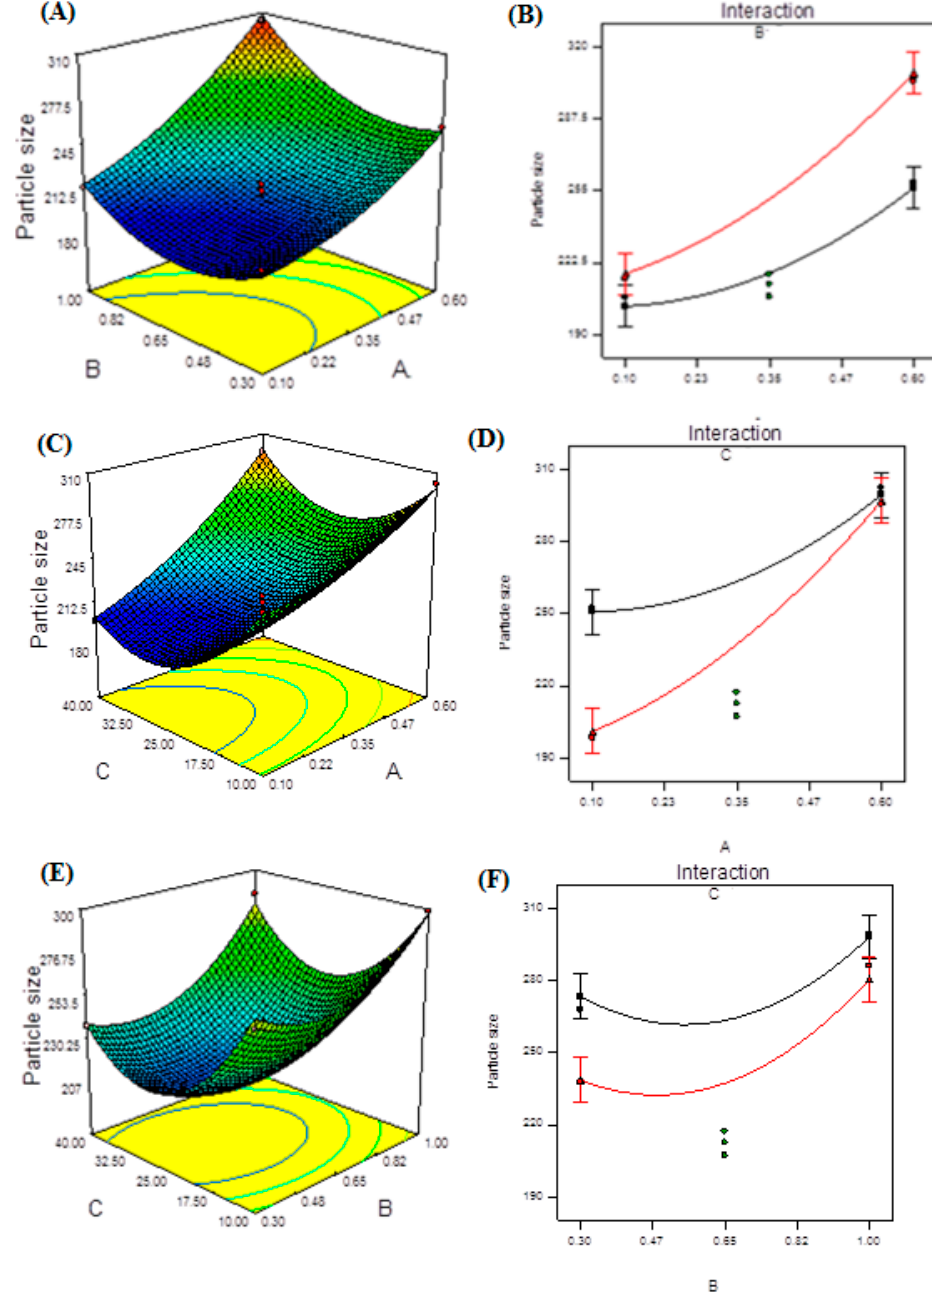
Figure 3. Model graphs: particle size. ( A ) Three-dimensional response surface plots showing the effect of variables (A: TPP concentration and B: CS concentration) on response (particle size), ( B ) interaction plot, ( C ) 3D response surface plots showing the effect of variables (A: TPP concentration and C: ultrasonication energy) on response (particle size), ( D ) interaction plot, ( E ) 3D response surface plots showing the effect of variables (B: CS concentration and C: ultrasonication energy) on response (particle size) and ( F ) interaction plot. Table 6. ANOVA for the response surface quadratic model.